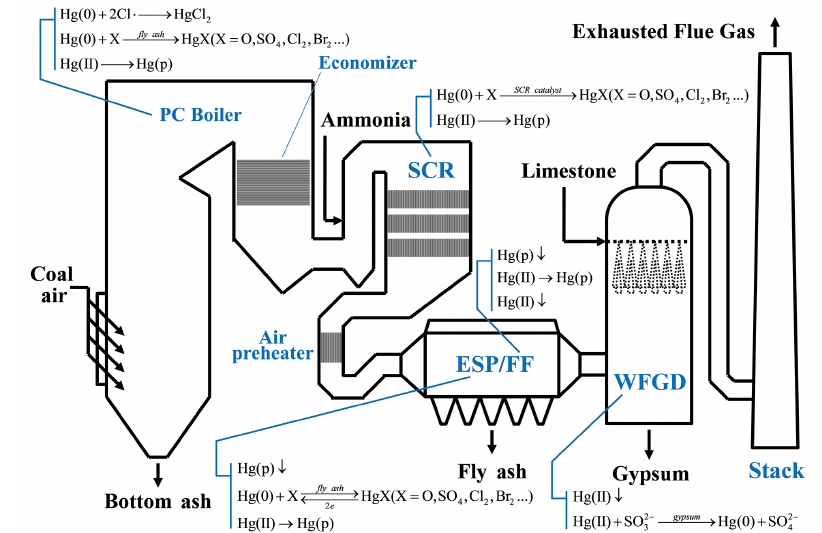
Figure 1. Mercury transformation and removal across APCDs in coal-fired power